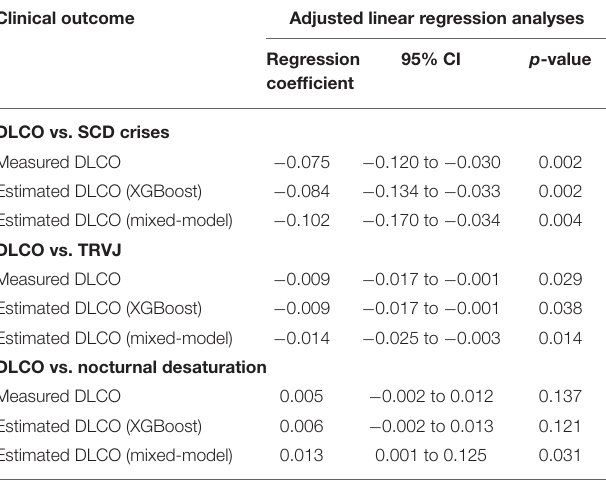
TABLE 4 | Adjusted analysis of DLCO vs. SCD clinical